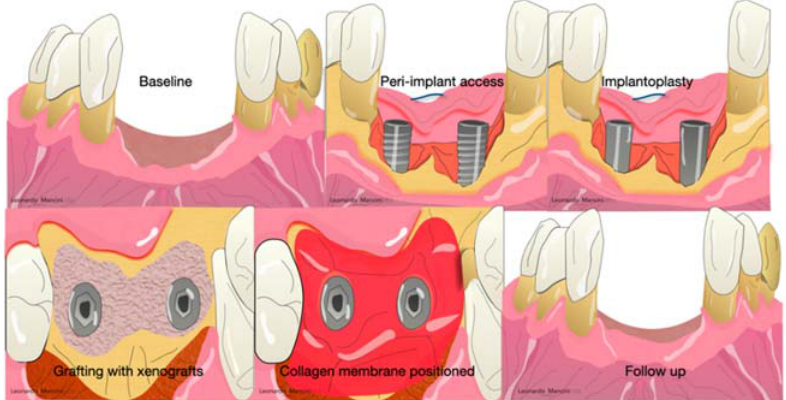
Figure 6. Example of peri ‐ implant regeneration after peri ‐ implantitis with xenografts and collagen membranes. After the peri ‐ implant access, a heavy implant debridement was achieved and an membranes. After the peri-implant access, a heavy implant debridement was achieved and an implantoplasty was mandatory to remove the infected surface. The peri ‐ implant defect was filled implantoplasty was mandatory to remove the infected surface. The peri-implant defect was filled with xenogeneic grafts and covered with a resorbable membrane. with xenogeneic grafts and covered with a resorbable